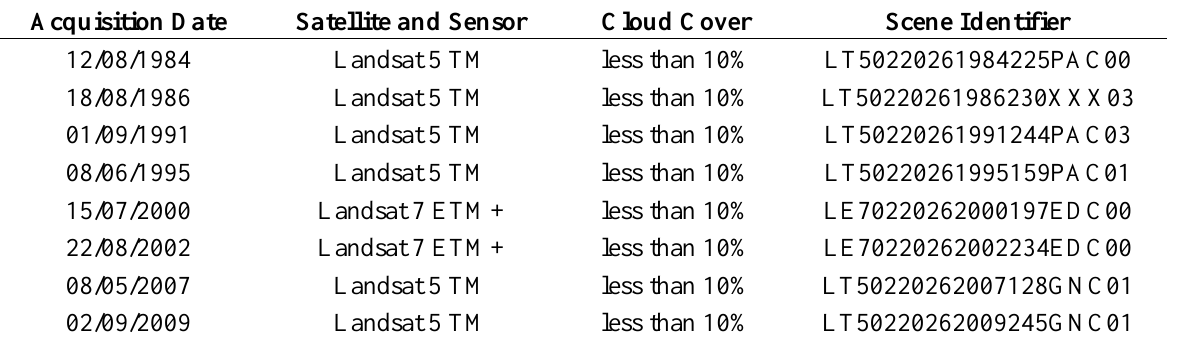
Table 1. Landsat image